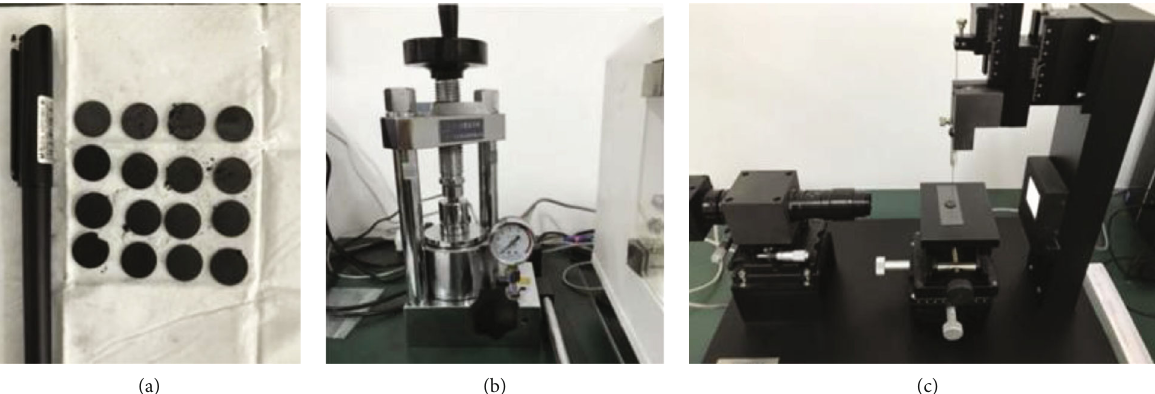
Figure 2: Sample preparation and measurement of contact angle ((a) pressed coal sheet sample, (b) YP-15 tablet machine, and (c) JC2000 video contact angle measuring